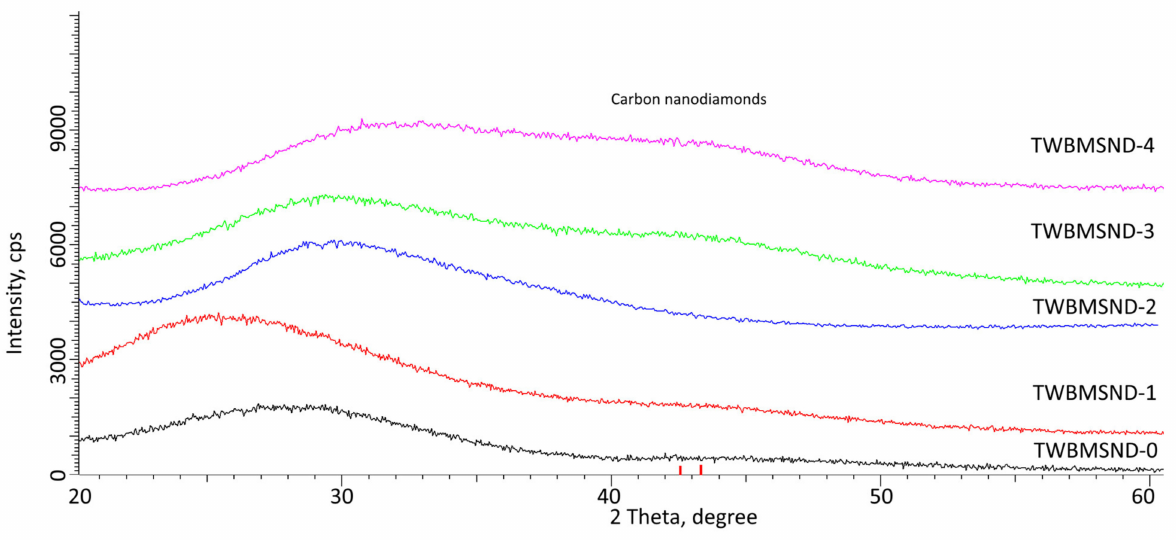
Figure 1. Results of X-ray diffraction of the studied glass compositions depending on the concentra- tion of CNDs (red dashed lines indicate the positions of reflections characteristic of